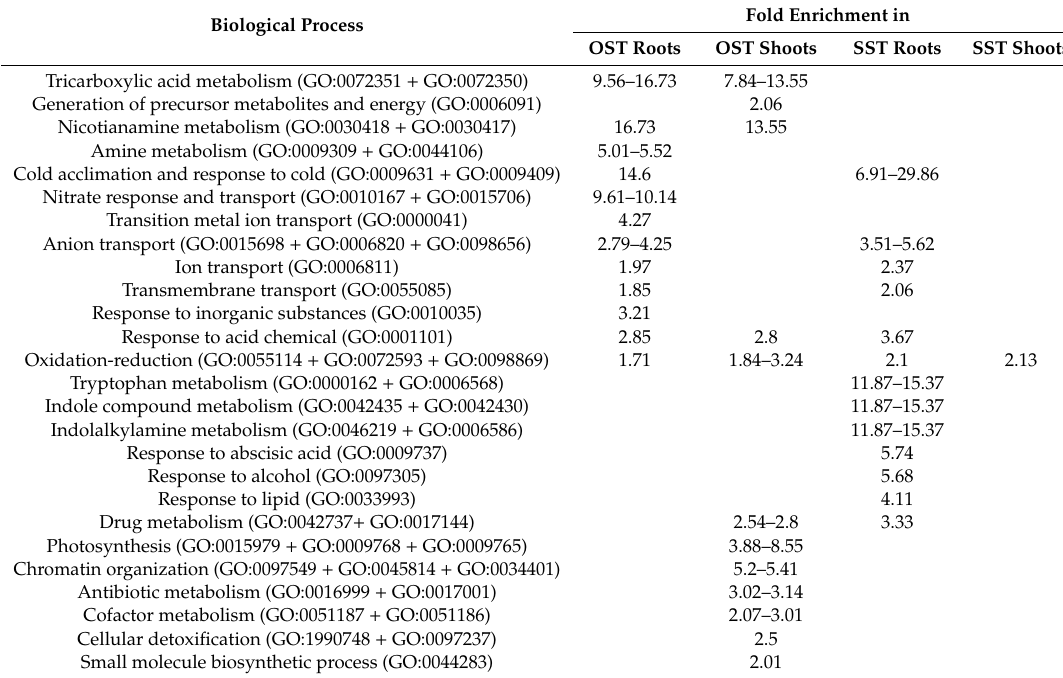
Table 2. Gene ontology (GO) term enrichment in the di ff erentially expressed genes (DEGs) from the specific tissue under osmotic or salt